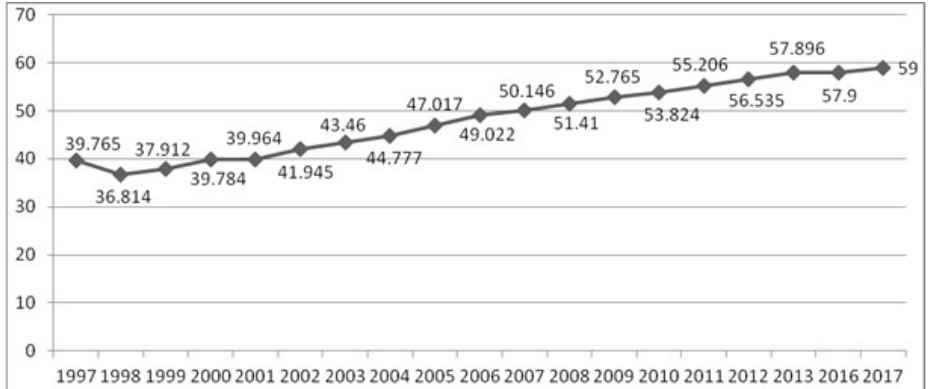
Figure 1. Total in all sectors, 1997- 2017 (million